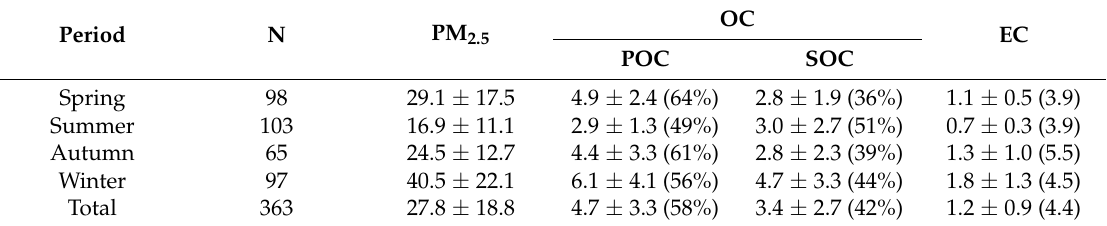
Table 3. Summarized results for PM 2.5 and its carbonaceous compounds. The unit of concentration is mg m − 3 and the values in parenthesis are the fractions of POC or SOC in total OC.